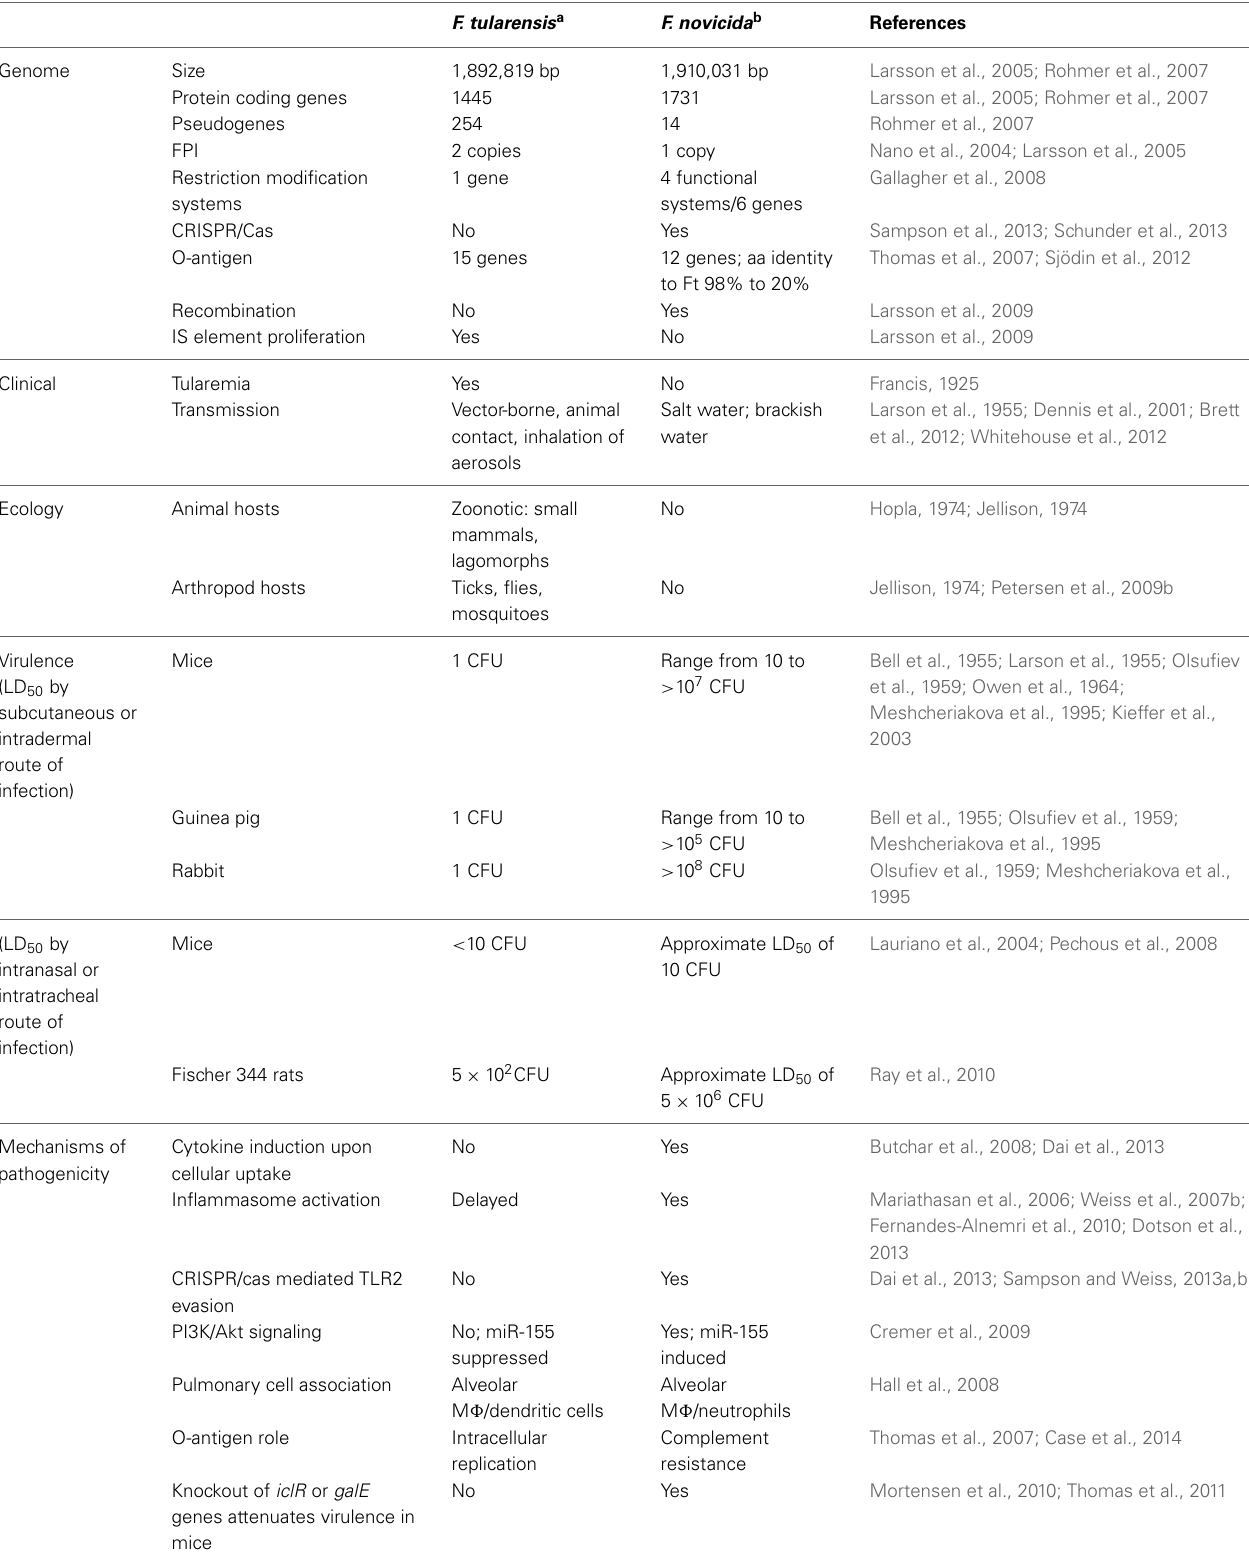
Table 1 | Genetic and phenotypic differences between F. tularensis and F. novicida